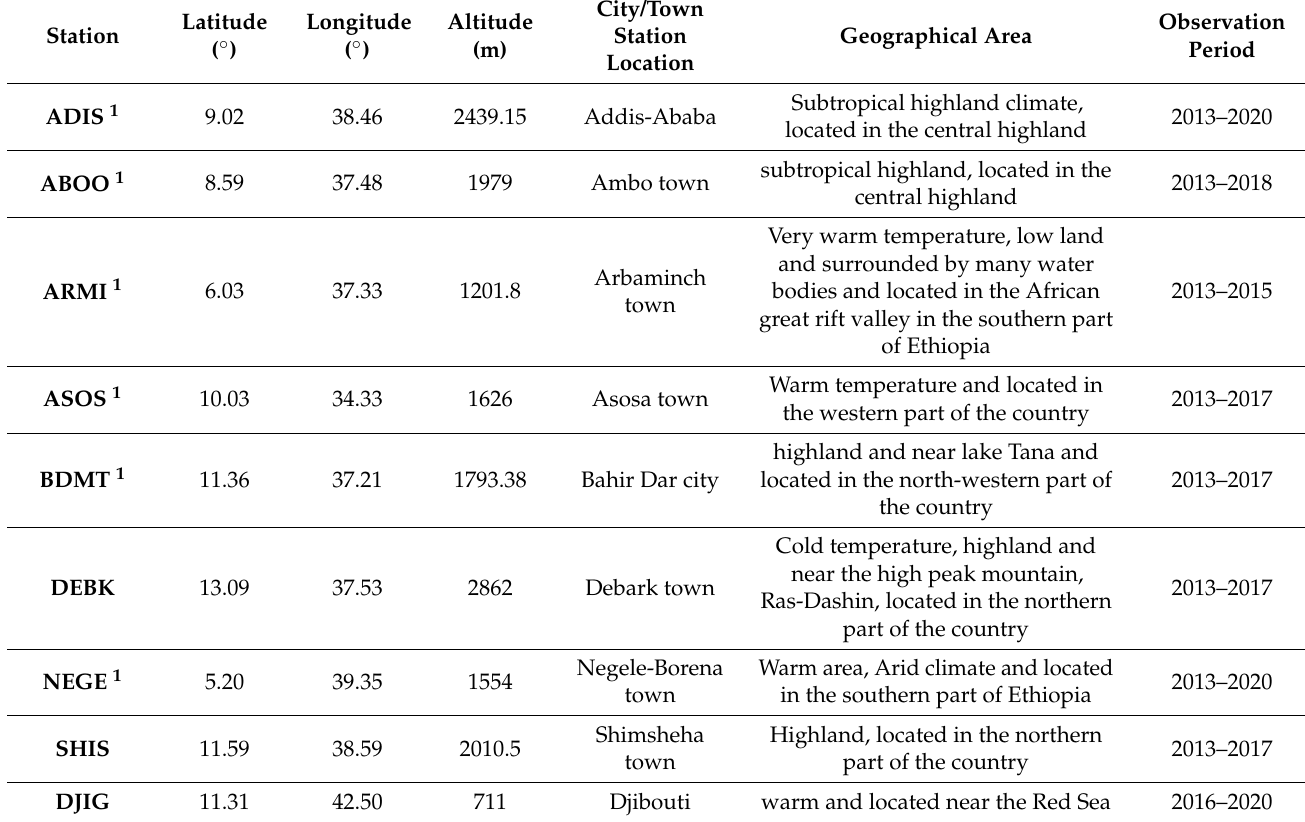
Table 1. GPS stations in Ethiopia with geographic area information and duration of observations time. Stations marked with 1 have surface observations of temperature and